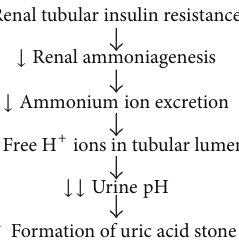
Figure 3: Pathophysiology of uric acid stone formation in metabolic syndrome patients